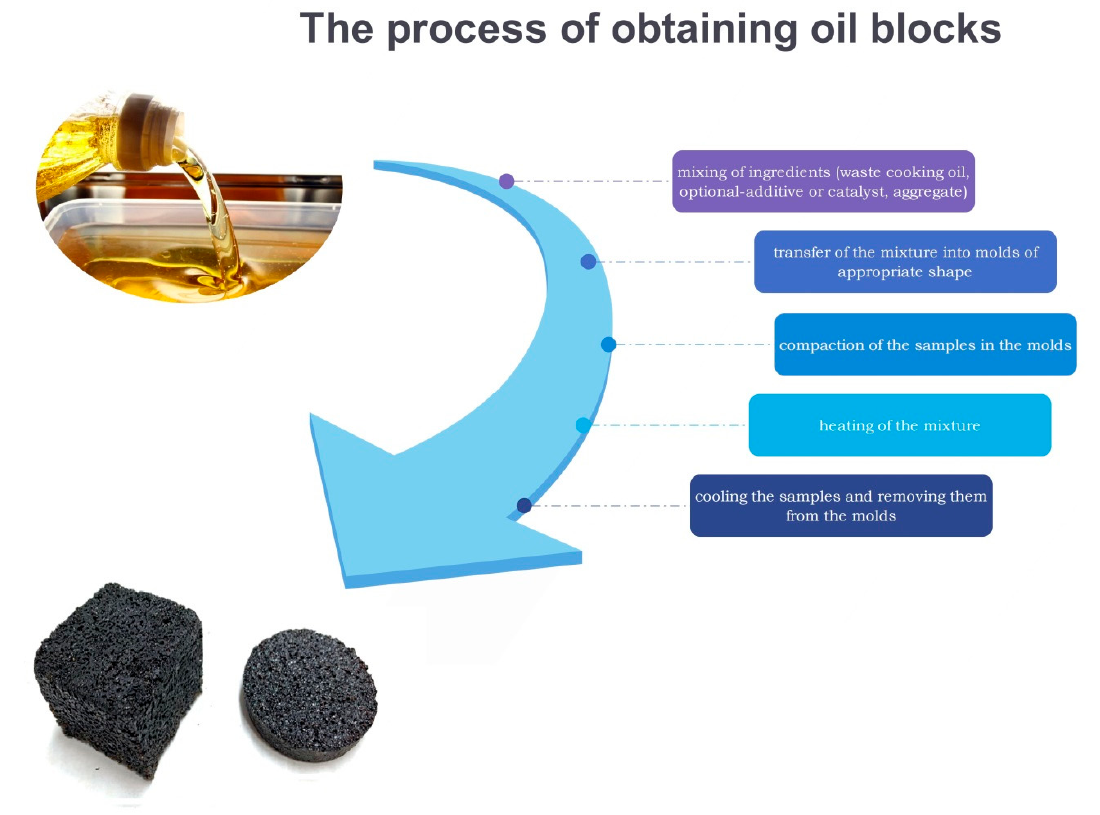
Figure 1. The stages in the process of oil blocks obtaining.